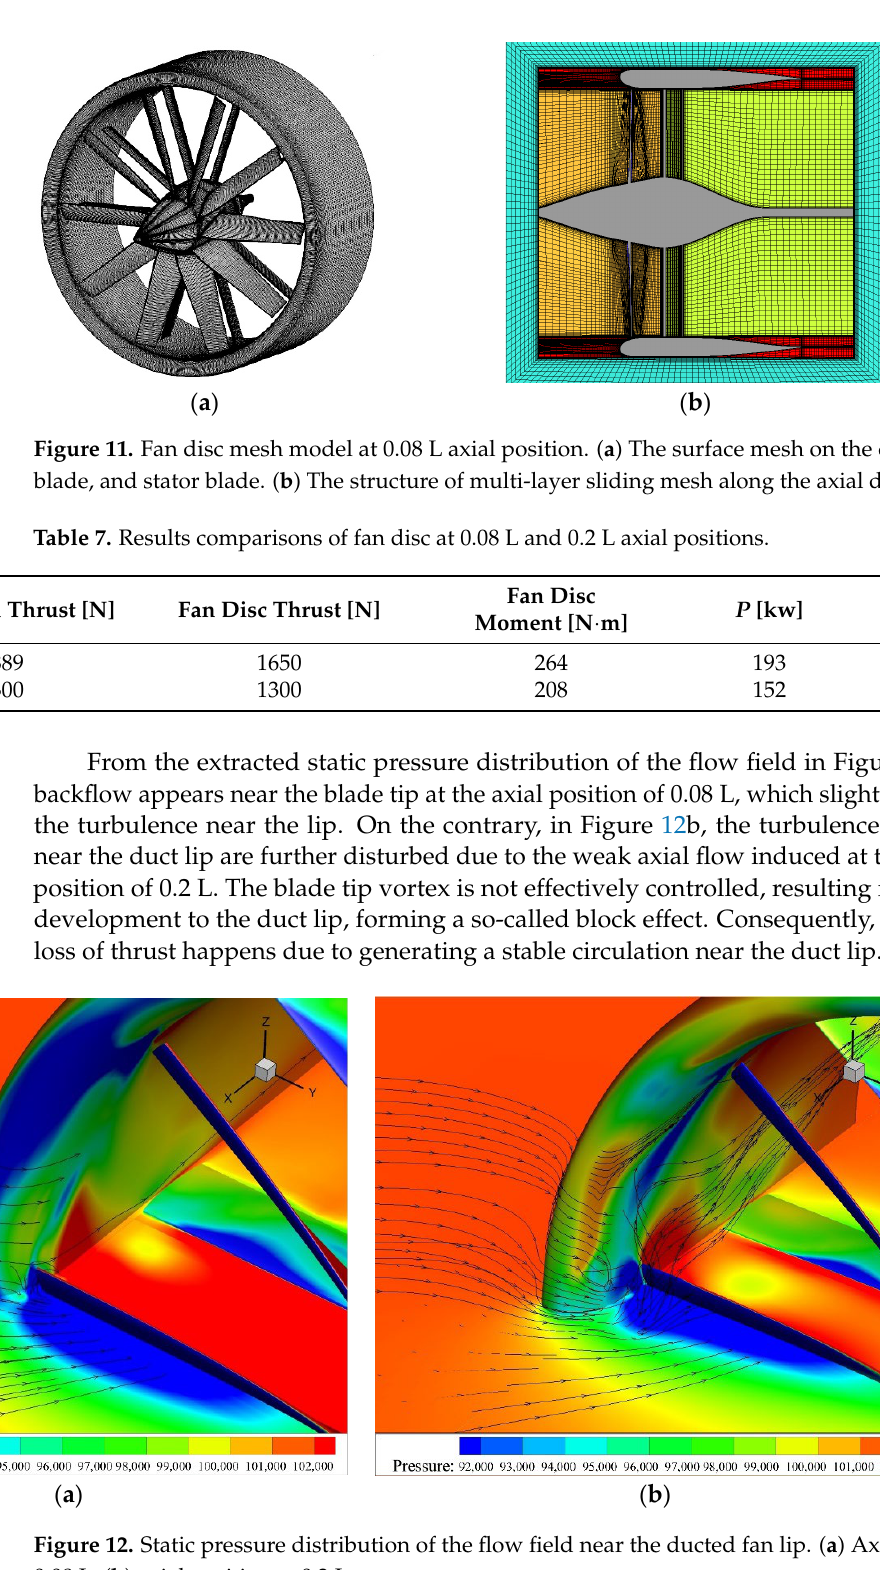
Figure 12. Static pressure distribution of the flow field near the ducted fan lip. ( a ) Axial position at 0.08 L; ( b ) axial position at 0.2 L.